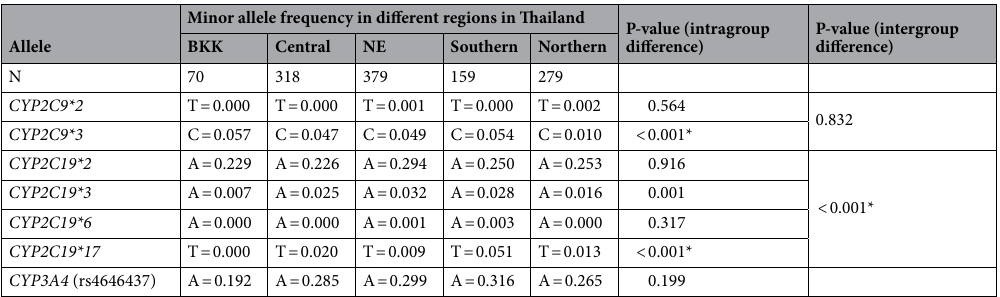
Table 3. Prevalence of CYP2C9 , CYP2C19 , and CYP3A4 alleles in different regions of Thailand (n = 1205). *Allele frequencies were compared in different regions of Thailand using χ 2 test, P-value < 0.05. BKK Bangkok, NE